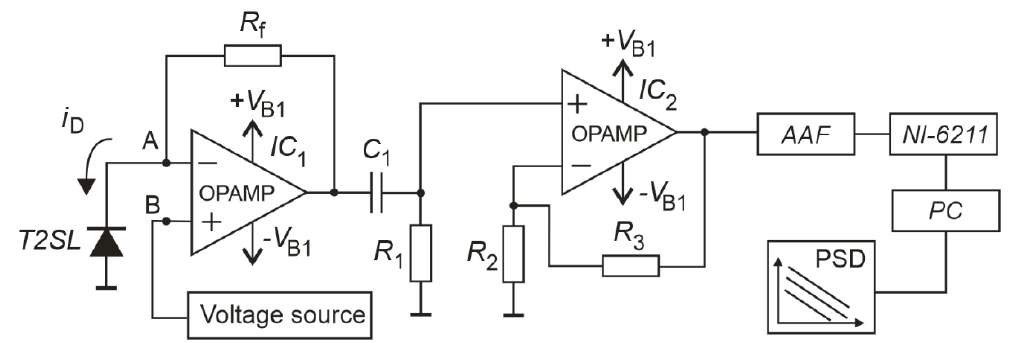
Figure 9. Schematic diagram of the Power Spectrum Density (PSD) measurements setup.